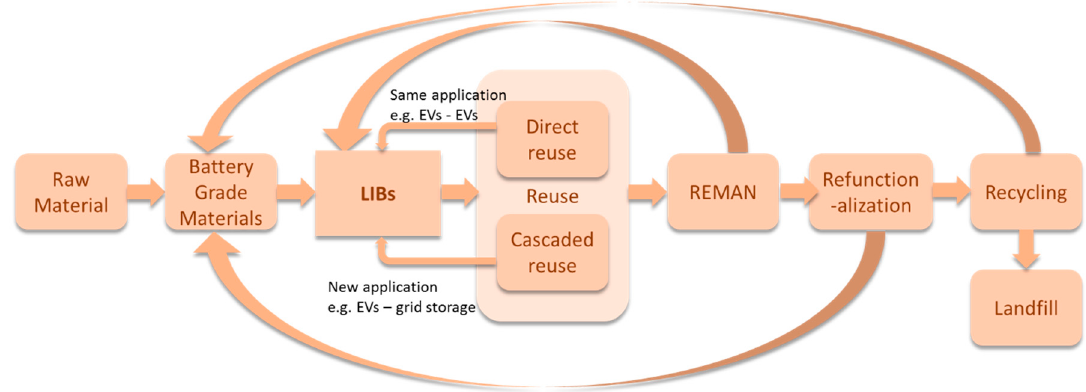
Figure 1 . Material Flow and Life Cycle Diagram of LIBs. Figure 1. Material Flow and Life Cycle Diagram of